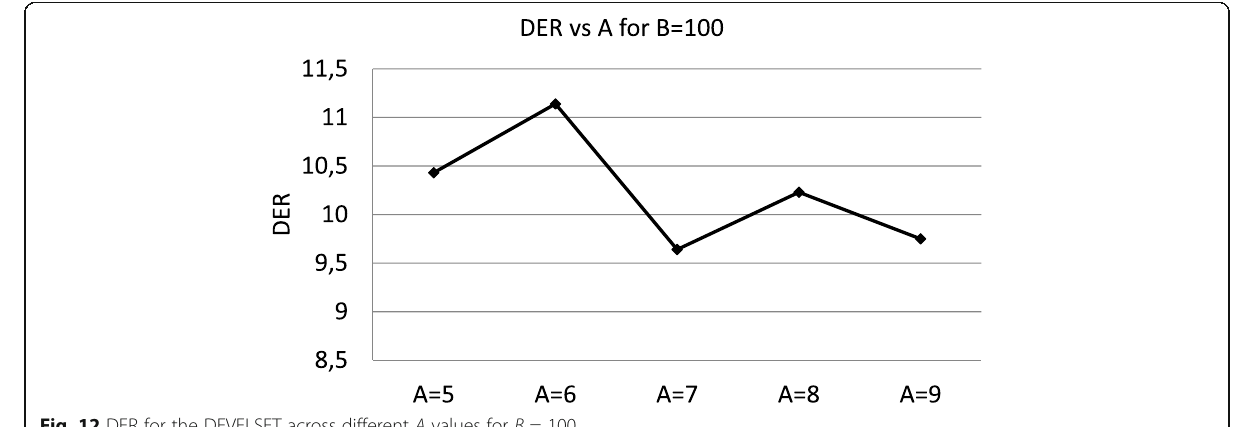
Fig. 12 DER for the DEVELSET across different A values for B =